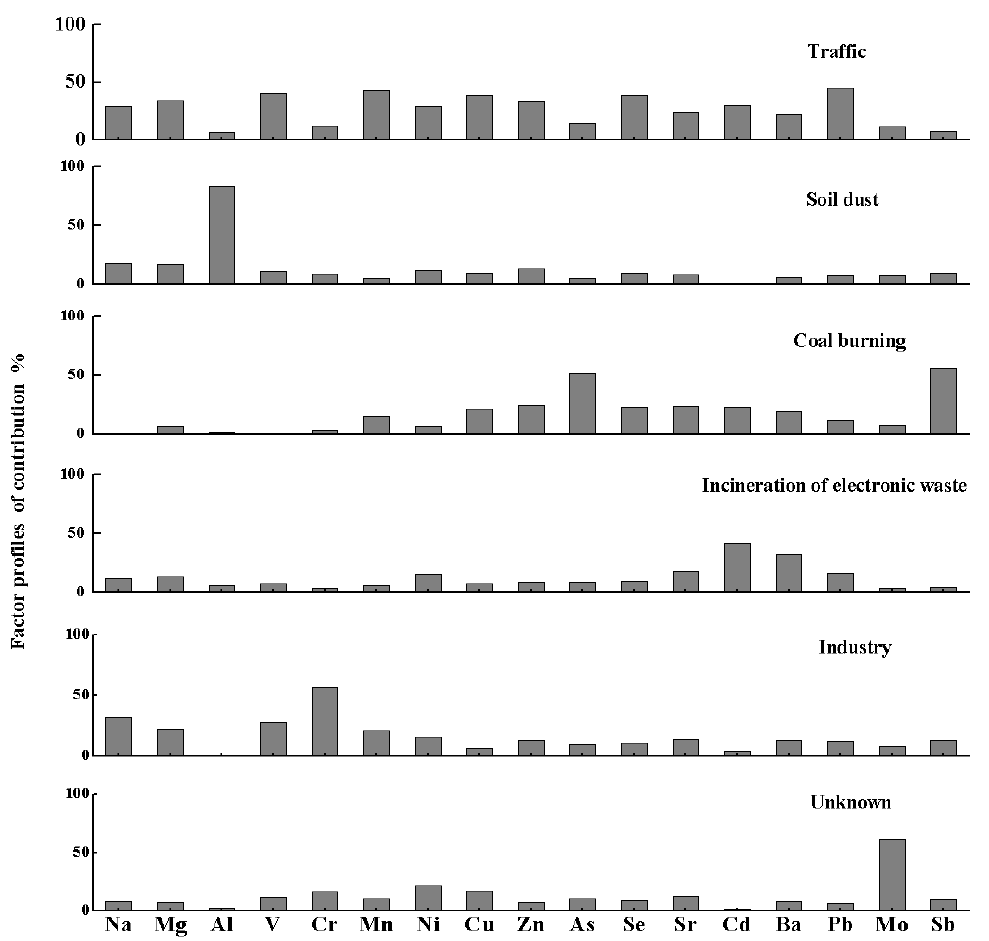
Figure 5. Contributions of metal elements to each sources (% of species total) analyzed by EPA positive matrix factorization (PMF).